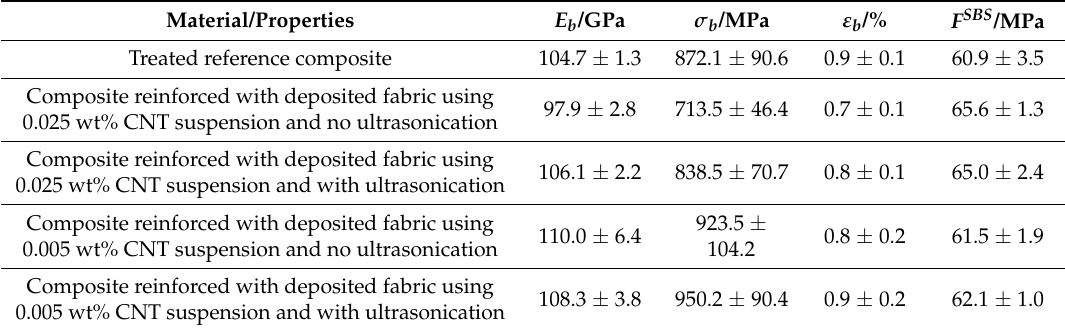
Table 2. Flexural properties and interlaminar shear strength of treated reference composite and composites reinforced with CNT-deposited CF fabric with and without ultrasonication being used during the continuous EPD